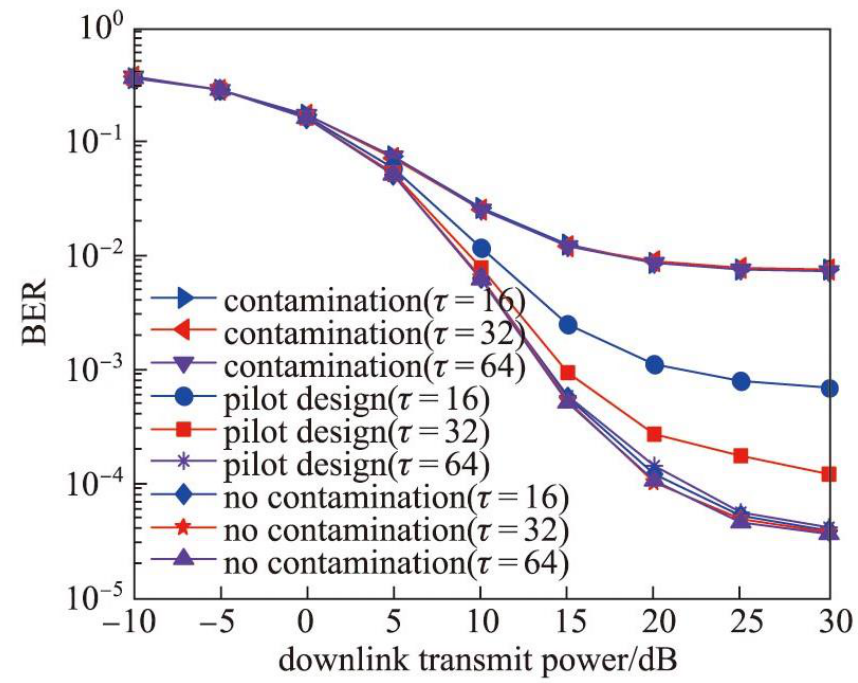
Figure 17. Comparison of the BER of the proposed pseudo-random code and another scheme versus the average BS power 𝜌 𝑓 .